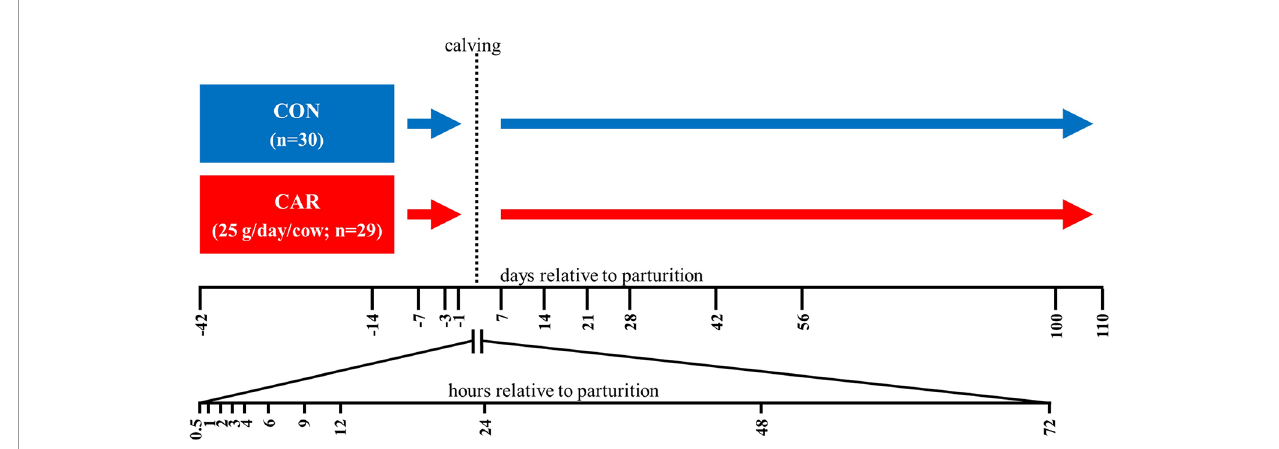
FIGURE 1 | Experimental design. The German Holstein dairy cows were assigned to a control (CON) or an L-carnitine supplemented group (CAR) (Carneon 20 Rumin-Pro, Kaesler Nutrition GmbH, Cuxhaven, Germany). To balance the fat content of the L-carnitine product, CON contained an equivalent fat product (BergaFat F-100 HP, Berg-Schmidt GmbH & Co. KG, Hamburg, Germany) as used for the rumen protection of the L-carnitine. Blood samples were collected from d 42 ante partum ( ap) until d 110 post-partum ( pp) and in a higher frequency during the fi rst 72 h pp . The number of cows actually sampled per experimental day and group were listed in the table